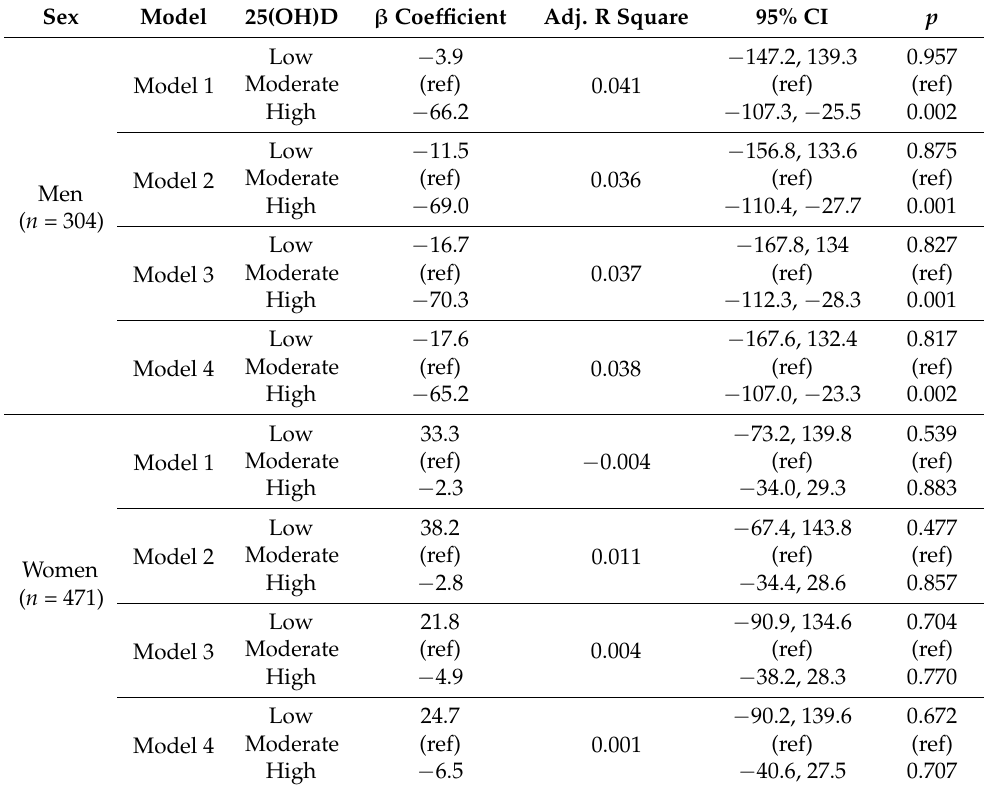
Table 5. Association between 25(OH)D cut-offs and telomere length by sex at 18